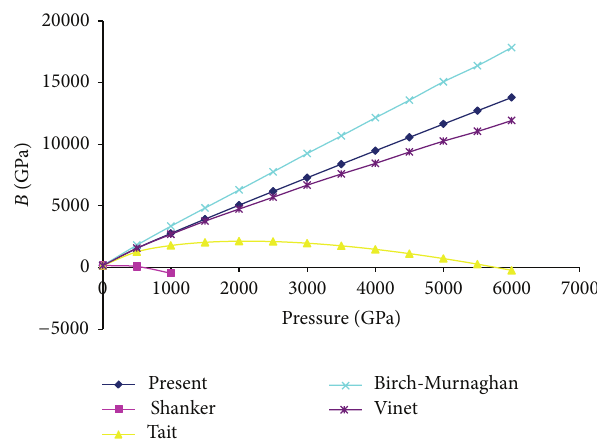
Figure 3: High pressure behavior of bulk modulus using different EOSs.